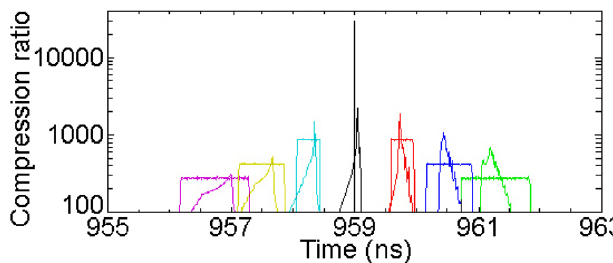
(cid:2) t (cid:3) =I (log scale) in the b 0